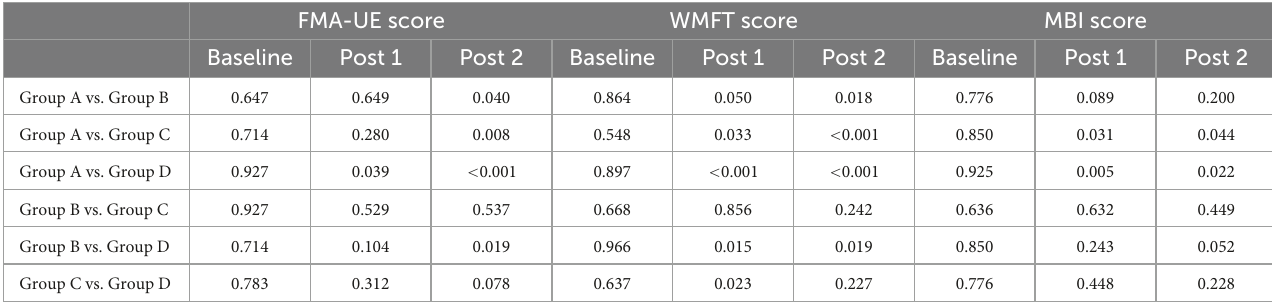
FMA-UE.Fugl-MeyerAssessmentUpperExtremityScale;WMFT,WolfMotorFunctionTest;MBI,ModifiedBarthelIndex. TABLE 6 Brunnstrom Stage of each group–upper limb.